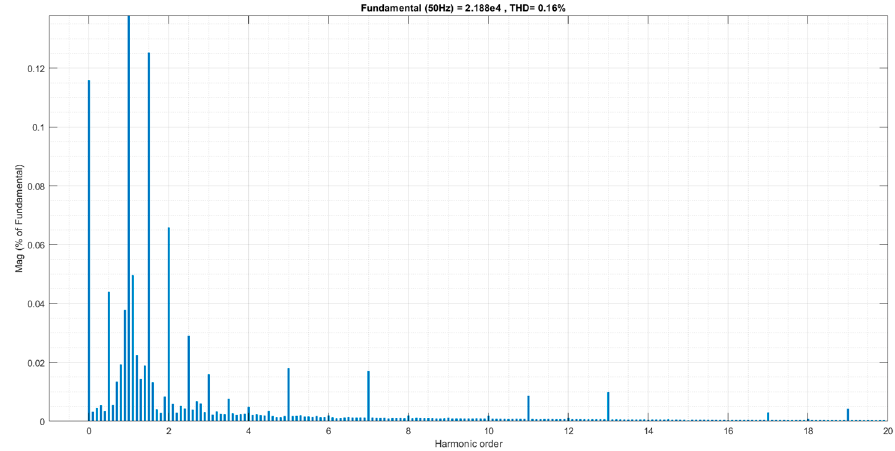
Figure 16. FFT analysis of output voltage of the PV station model.